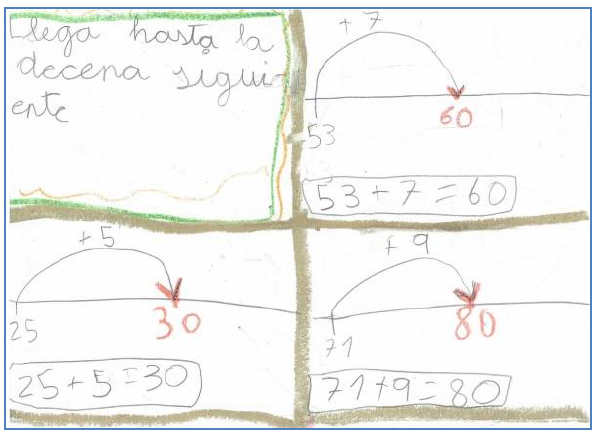
Figure 8. Get next ten.